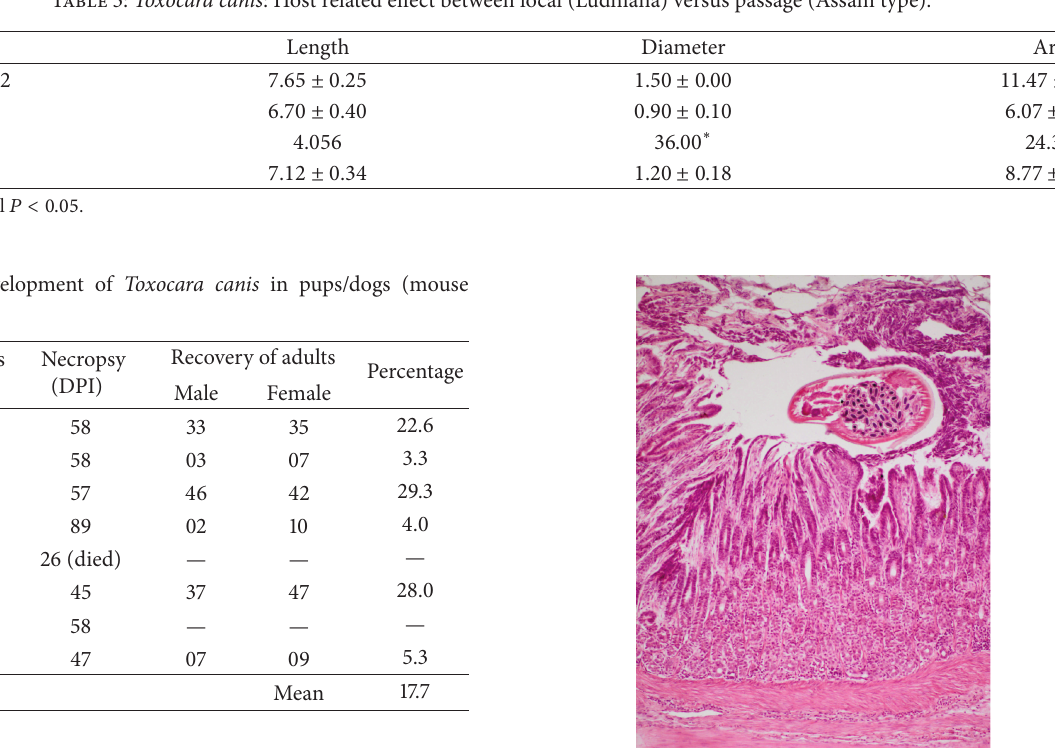
Table 3: Toxocara canis : Host related effect between local (Ludhiana) versus passage (Assam type).